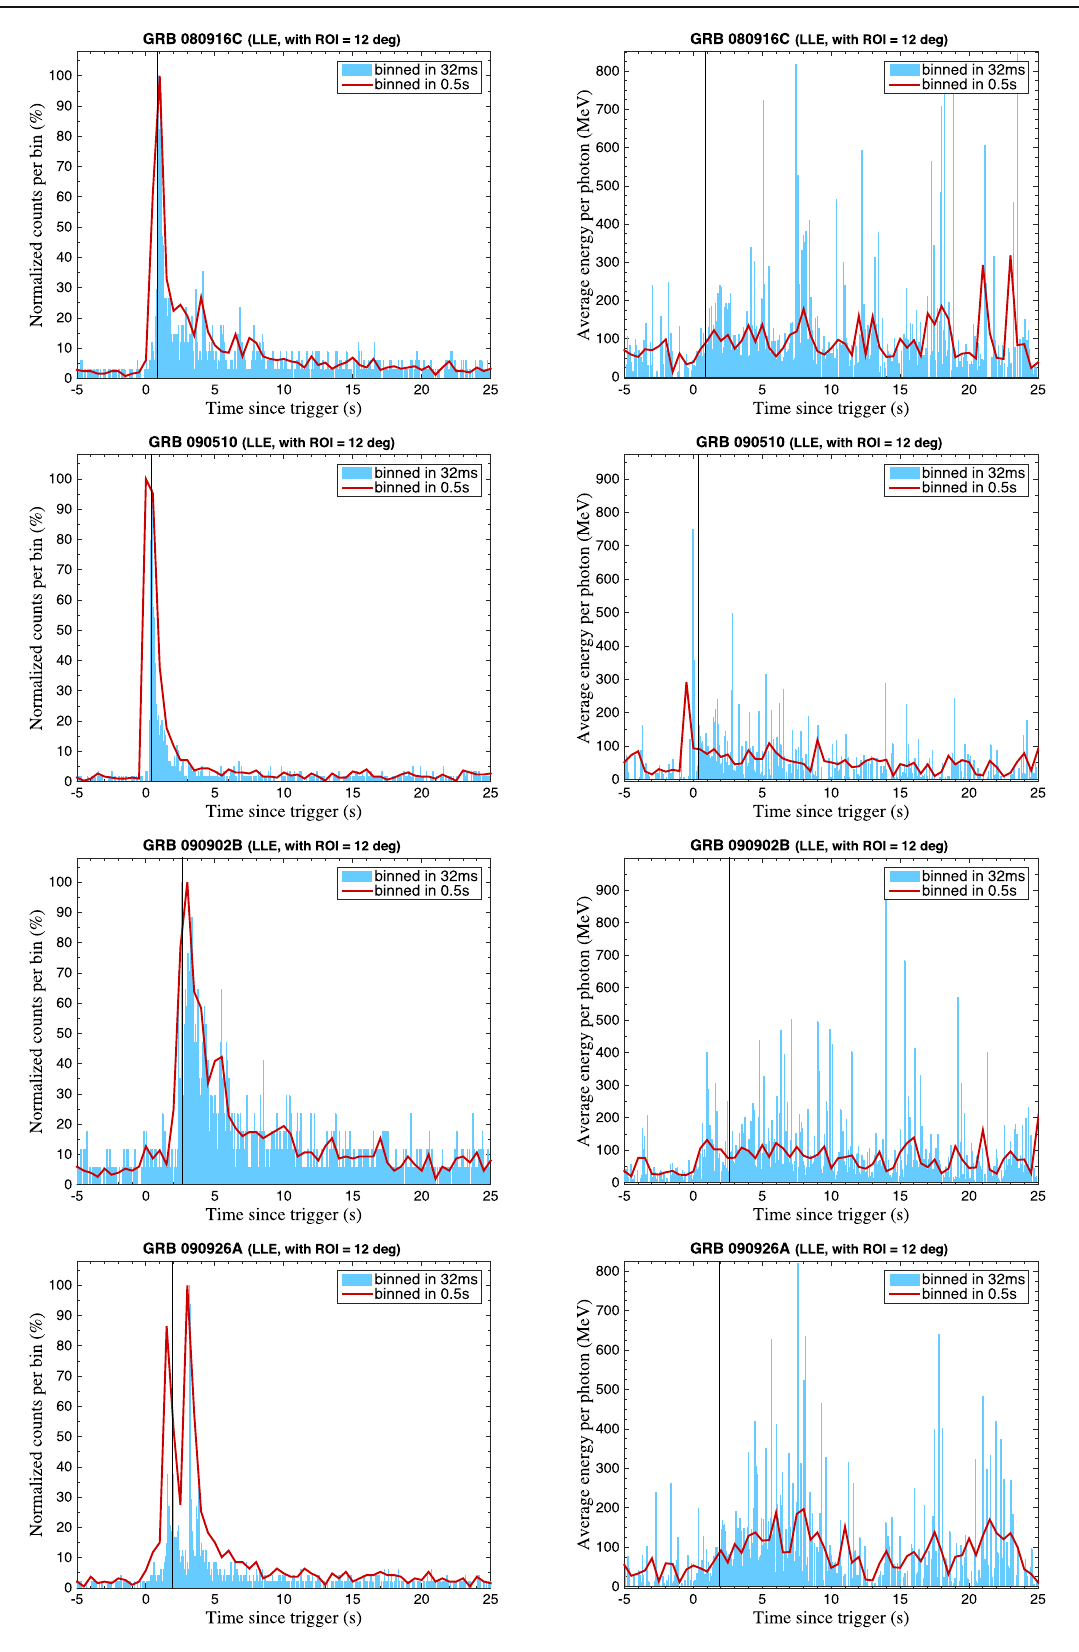
Fig. 21 Curves in Set-LLE (part 1): light curves and average energy curves of LLE